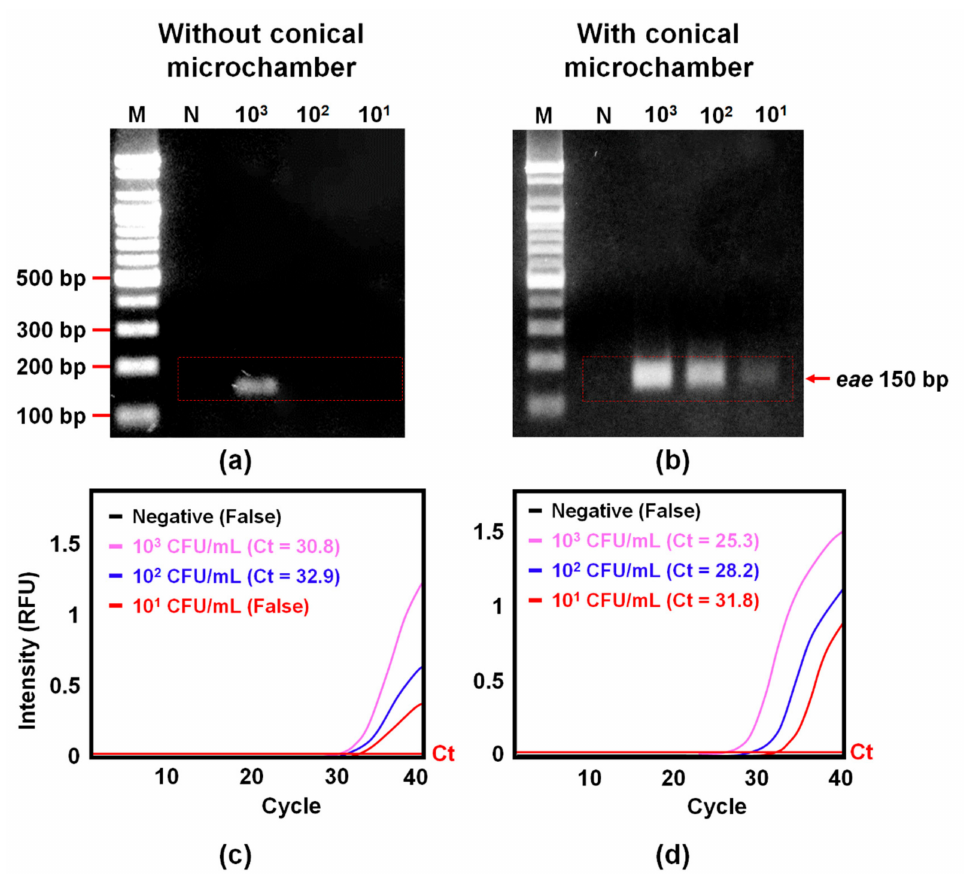
Figure 6. Confirmation of E. coli O157:H7 preconcentration and gDNA extraction e ffi ciency using either PCR with gel electrophoresis ( a and b ) or qPCR ( c and d ) on the W-shaped microchannel with and without the conical microchamber. Blood samples (2.5 mL) containing E. coli O157:H7 at di ff erent concentrations (10 1 –10 3 CFU / mL) were processed with the W-shaped microchannel either without the chamber (a and c) or with the chamber (b and d) before PCR and qPCR. Ct: cycle of